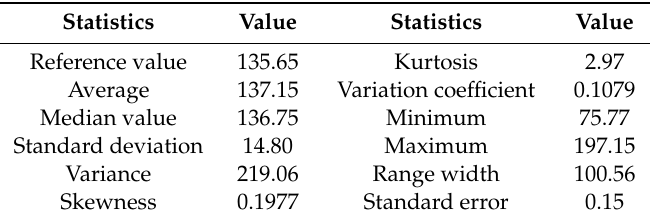
Table 4. Residential solar LCOE